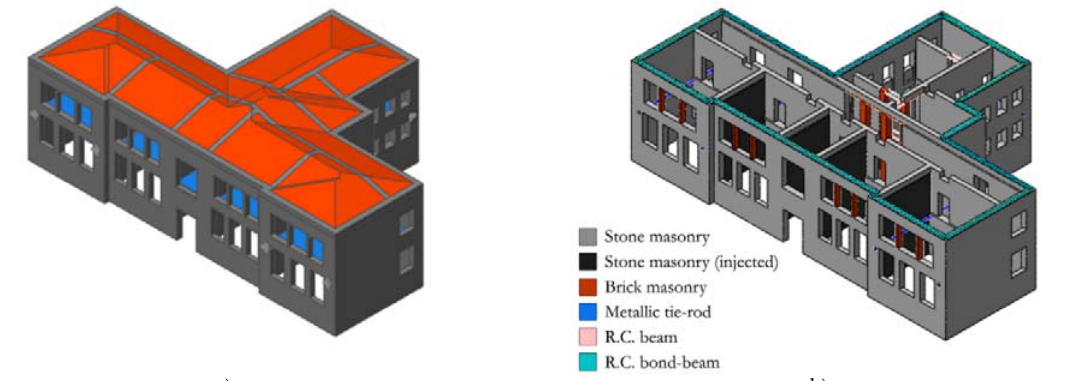
Figure 10: Three-dimensional model: a) geometry, b) description of the materials (slabs and roof are not represented). Material and diaphragm properties